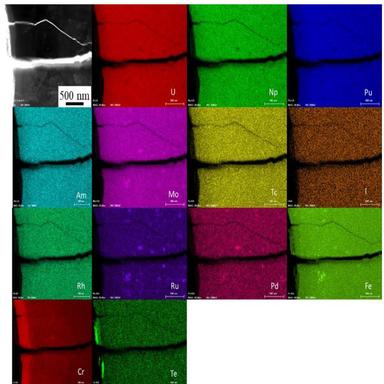
The EDS maps form TEM foil A in 6. These are intensity maps are at the FCCI/Fuel boundary. The maps show an enrichment of Cr in the FCCI layer and Te enrichments at the end of cracks in the fuel. In addition, Fe in small precipitates can be observed.